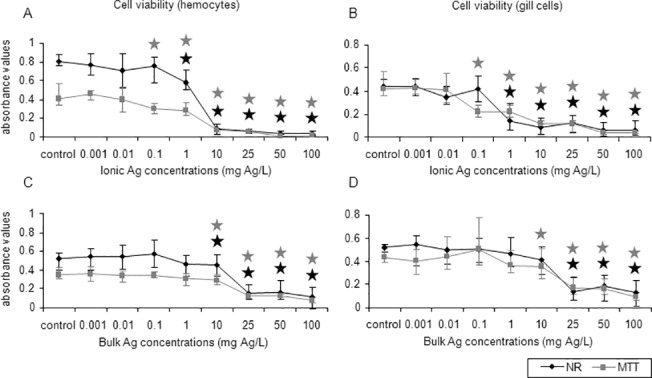
Effects of ionic and bulk Ag on mussel cells viability.Cell viability (NR and MTT assays) in mussel hemocytes and gill cells exposed to ionic Ag (A and B) and bulk Ag (C and D) for 24 h. Data are given as absorbance values (means ± confidence intervals). Stars indicate significant differences (p<0.05) in treated cells with respect to controls according to the bootstrap analysis followed by Bonferroni’s correction. Black stars correspond to the NR assay and grey stars to the MTT assay. n = 6 replicates per treatment.